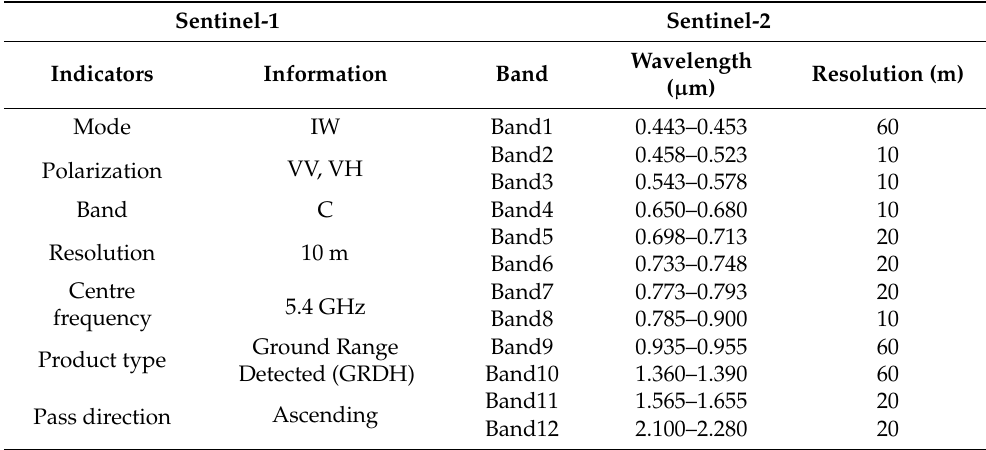
Figure 3. Field survey calendar and available remote sensing images within 2018–2020. Table 1. Main parameters of the used Sentinel-1 and Sentinel-2